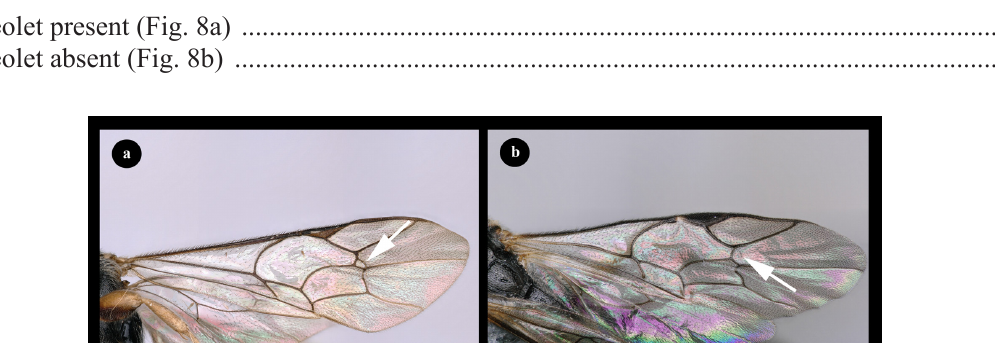
Fig. 7a points to inflated upper part of pronotum (compared to normally curved upper part of pronotum in Fig. 7d). Arrow in Fig. 7b points to lobe like upper tooth of mandible (compared to triangular, acutely pointed upper tooth of mandible in Fig. 7e). Arrow in Fig. 7c points to the presence of a sharp transverse carina separating interantennal processes and upper face (compared to the absence of transverse carina separating interantennal processes and upper face in Fig. 7f).